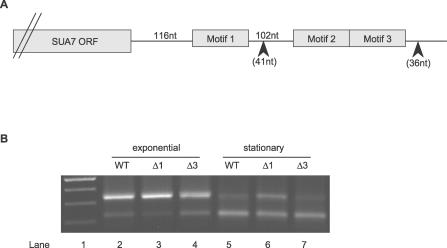
Removal of Nab4 Motifs Alters Cleavage Site Selection(A) Schematic of the layout of Nab4 motifs in the SUA7 3′ UTR. Motifs are numbered from their distance from the stop codon. The median position of the cleavage sites as mapped by Hoopes et al. is noted by an arrowhead. The distance from the adjacent upstream motif is noted in parentheses.(B) 3′ RACE analysis of the SUA7 transcript with motif mutations from wild-type. The Nab4 motifs were removed from SUA7 and replaced with a heterologous sequence. 3′ RACE was performed on strains expressing only the mutant version of SUA7. Both log phase (lanes 2–4) and stationary phase (lanes 5–7) were analyzed. Δ1, motif 1 mutated; Δ3, motif 3 mutated. nt, nucleotide; WT, wild-type.